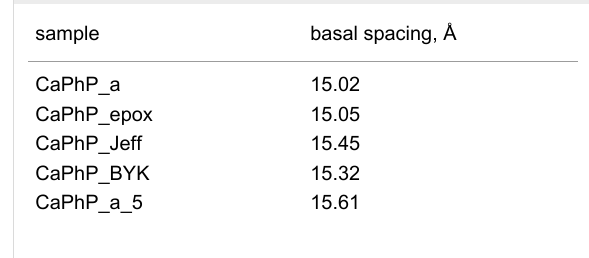
Table 1: Comparison of the basal spacings for calcium phenylphos- phonate alone, as a filler in the free film and its mixtures with indi- vidual components of the polymer